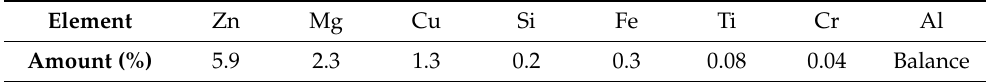
Table 1. Chemical composition of AA 7075.